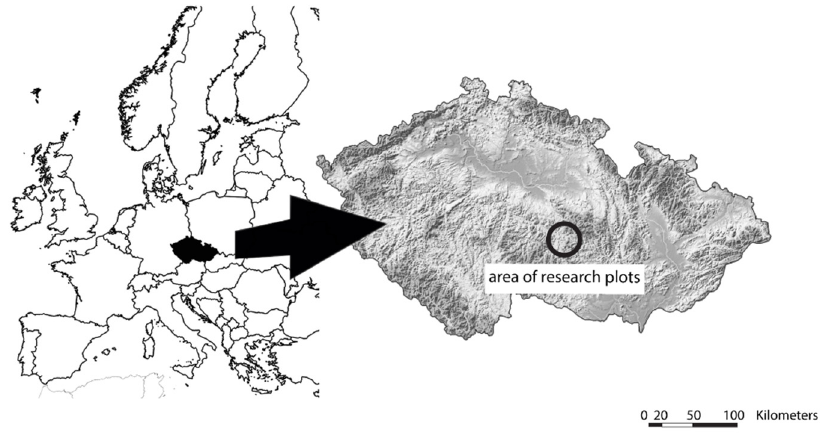
Figure 1. Location of research plots for applied measurements showing the positions both within Europe and the Czech Republic.